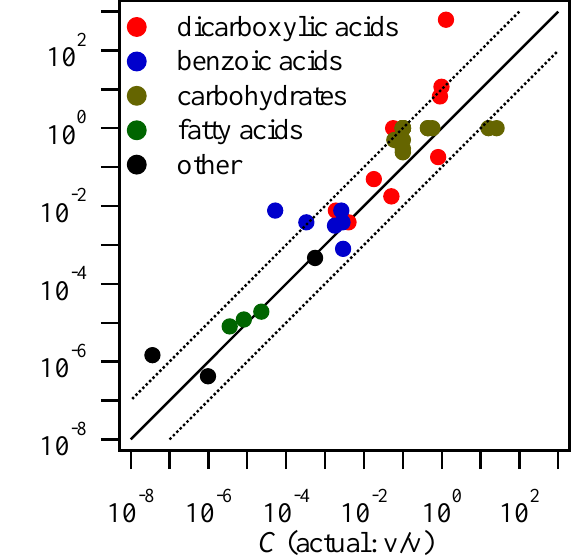
Fig. 4. Comparison of predicted C (i.e., by O:C ratio in Eq. 7) to its actual value. The solid line denotes a 1 : 1 line. The dashed lines correspond to 10-fold differences from the predictions of Eq. (7). The figure omits soluble polymers because they are miscible with